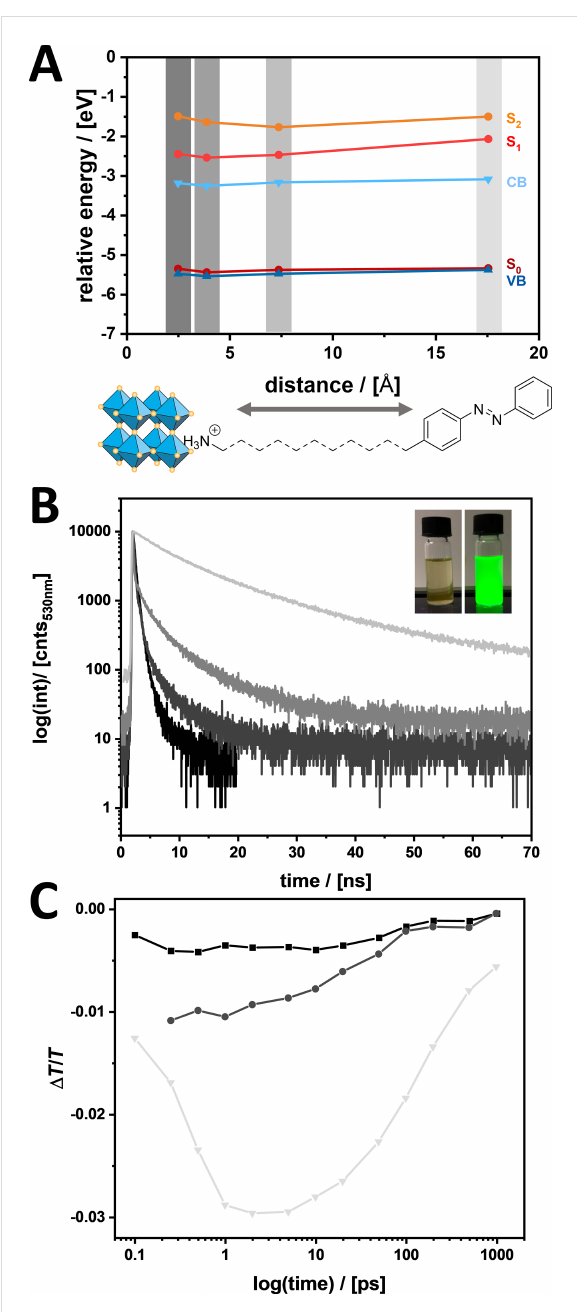
Figure 6: (A) Relative energy of MOs (S 0 , S 1 and S 2 ; see Table 2) of the azobenzene ligands and VB and CB of the perovskite particles in dependence on the distance between the perovskite and the azoben- zene group. (B) Time-dependent PL measurements of a dispersion of 3D-AzoC 1 (black), 3D-AzoC 2 (dark grey), 3D-AzoOC 4 (grey) and 3D-AzoOC 12 (light grey). Excitation at λ exc = 405 nm and recorded emission at λ em = 530 nm. Top right: photography of 3D-AzoC 2 dispersed in toluene (left) and alkyl-functionalized perovskite particles under illumination at 254 nm. (C) Decay of the ground state bleach ob- tained after an excitation pulse at 398 nm of transient absorption (TA) measurements for 3D-AzoC 1 (at 522.5 nm, in black), 3D-AzoC 2 (at 500 nm, in dark grey) and 3D-AzoOC 12 (at 515 nm, in light grey), the original spectra can be found in Supporting Information File 1, Figure